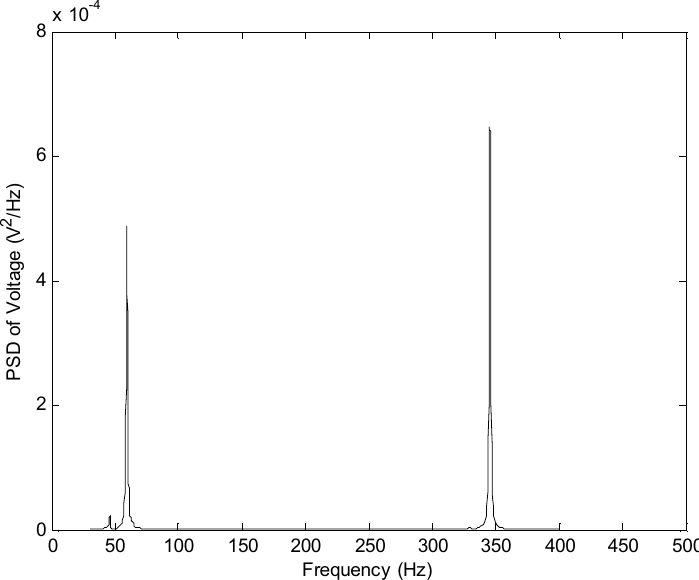
Fig. 19. PZT sensor voltage for the system rotating at 40 Hz. A vertical step force of white noise is acting at the tip of the blade where PZT sensor is mounted. To simulate such excitation conditions a sinusoidal tip force of magnitude 1.735 N is applied. The frequency